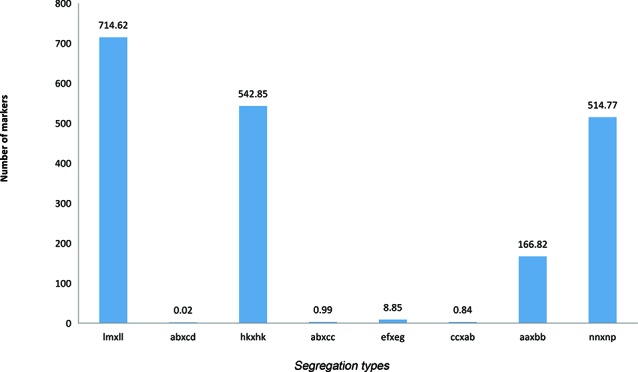
Segregation types of polymorphic SNP markers. The x axis indicates the eight segregation types; the y axis indicates the corresponding number of markers.